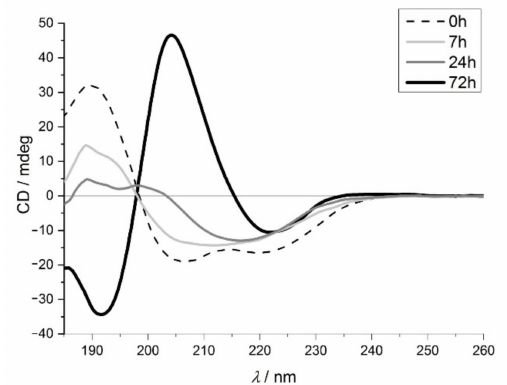
Figure 3. Far-UV ECD spectra of the Exendin-4 derivative miniprotein (E5) after 0 h (dashed line), 7 h (light grey), 24 h (grey), 72 h (black) incubation.